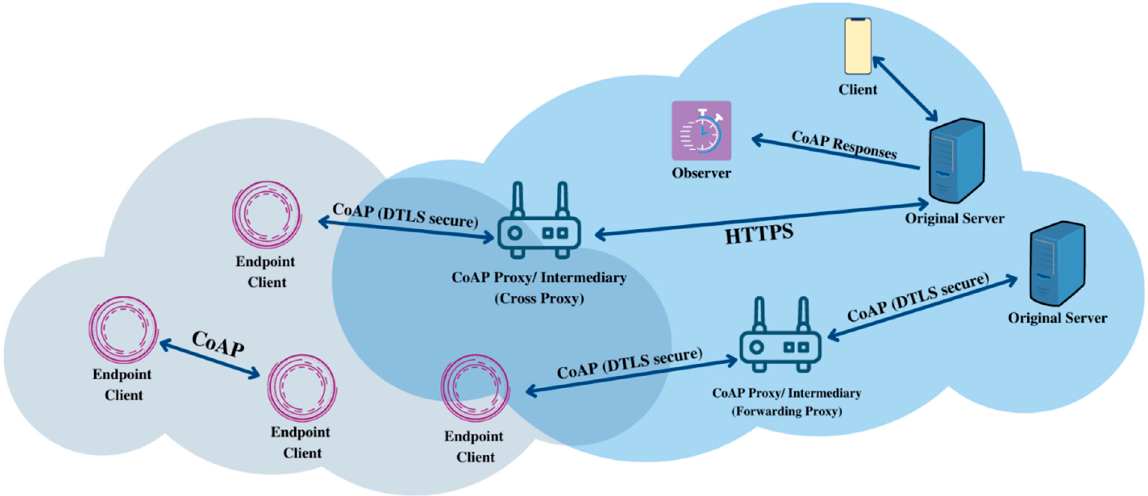
Figure 16. The architecture of CoAP. A proxy or intermediary maps the HTTP and CoAP protocols between origin servers and clients.